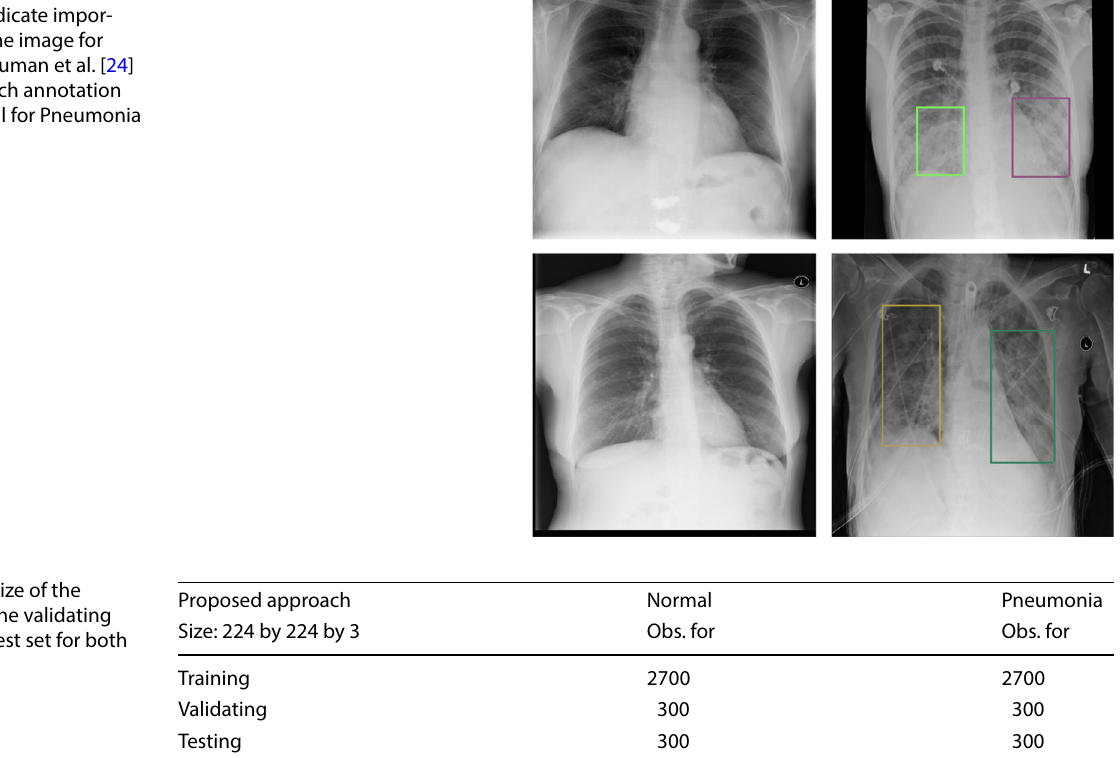
Fig. 6 The lung anatomy and several annotated boxes doc- tors use to indicate impor- tant area in the image for diagnosis. Neuman et al. [24] suggested such annotation can be helpful for Pneumonia diagnosis